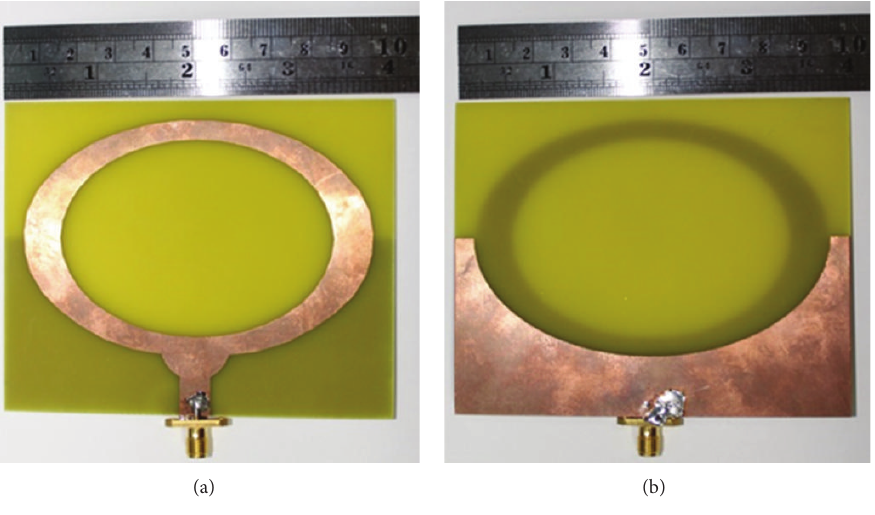
Figure 4: Prototype of the proposed antenna.